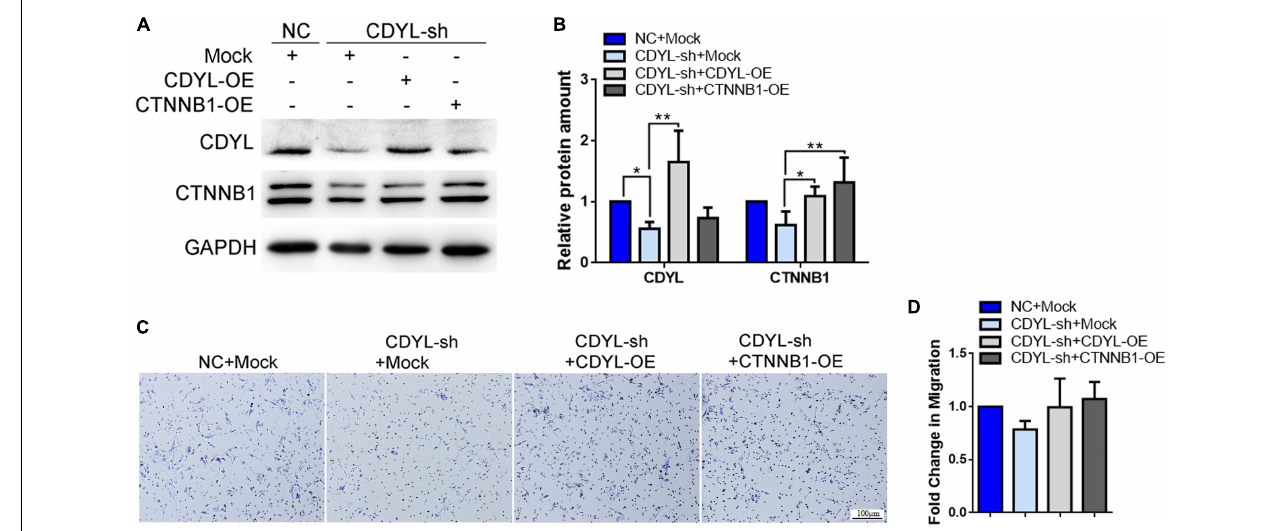
FIGURE 8 | Effects of CDYL knockdown/over-expression on the expression of CTNNB1 and cell migration in primary endometrial epithelial cells. (A,B) Effects of CDYL on CTNNB1 expression level in EECs by Western blot analysis. (C,D) Effects of CDYL on cell migration in EECs by transwell migration assay. Bar = 100 µ m. N = 3. All data are presented as mean ± SD. * P < 0.05; ** P < 0.01.